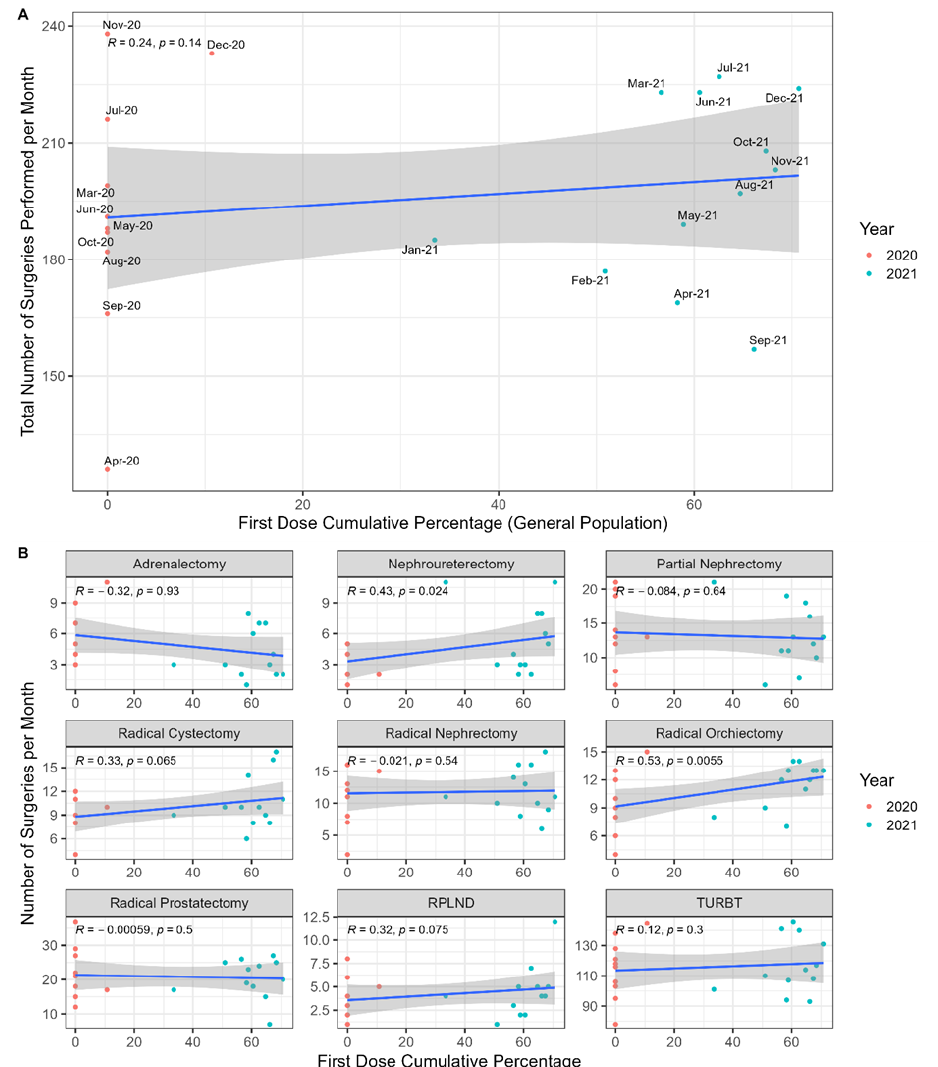
Figure 6. ( A ) Correlation between the first vaccination dose and the total number of urologic surgeries per month. ( B ) Subgroup analysis per surgery